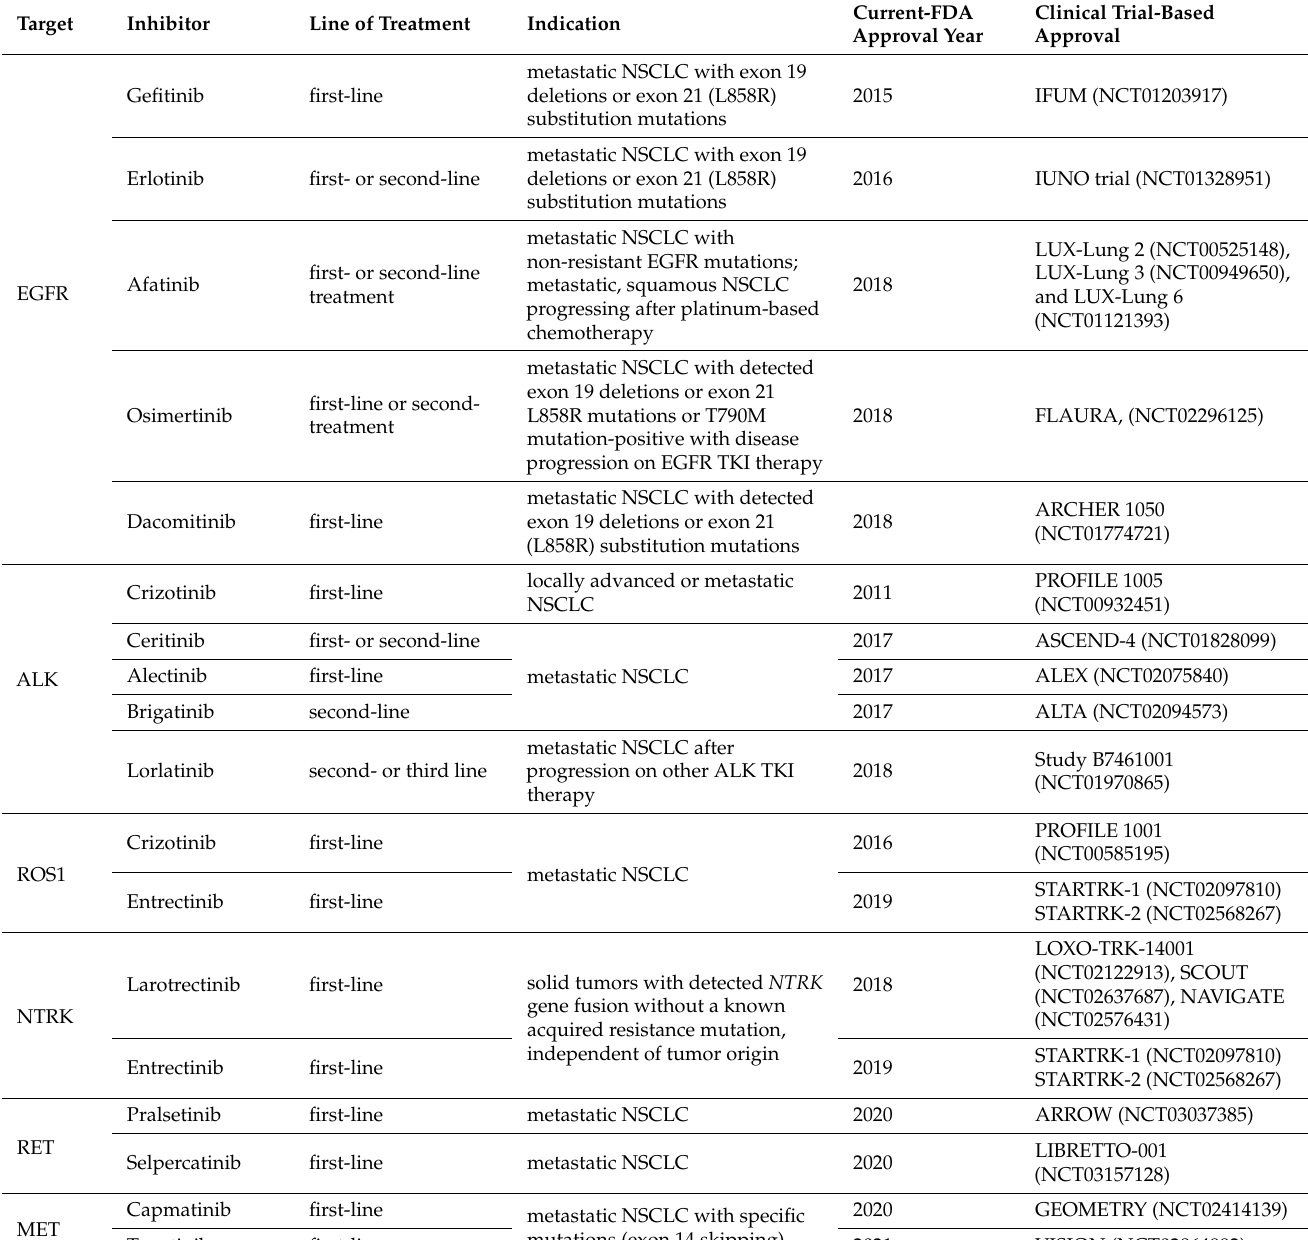
Table 2. FDA-approved targeted therapy drugs for the treatment of